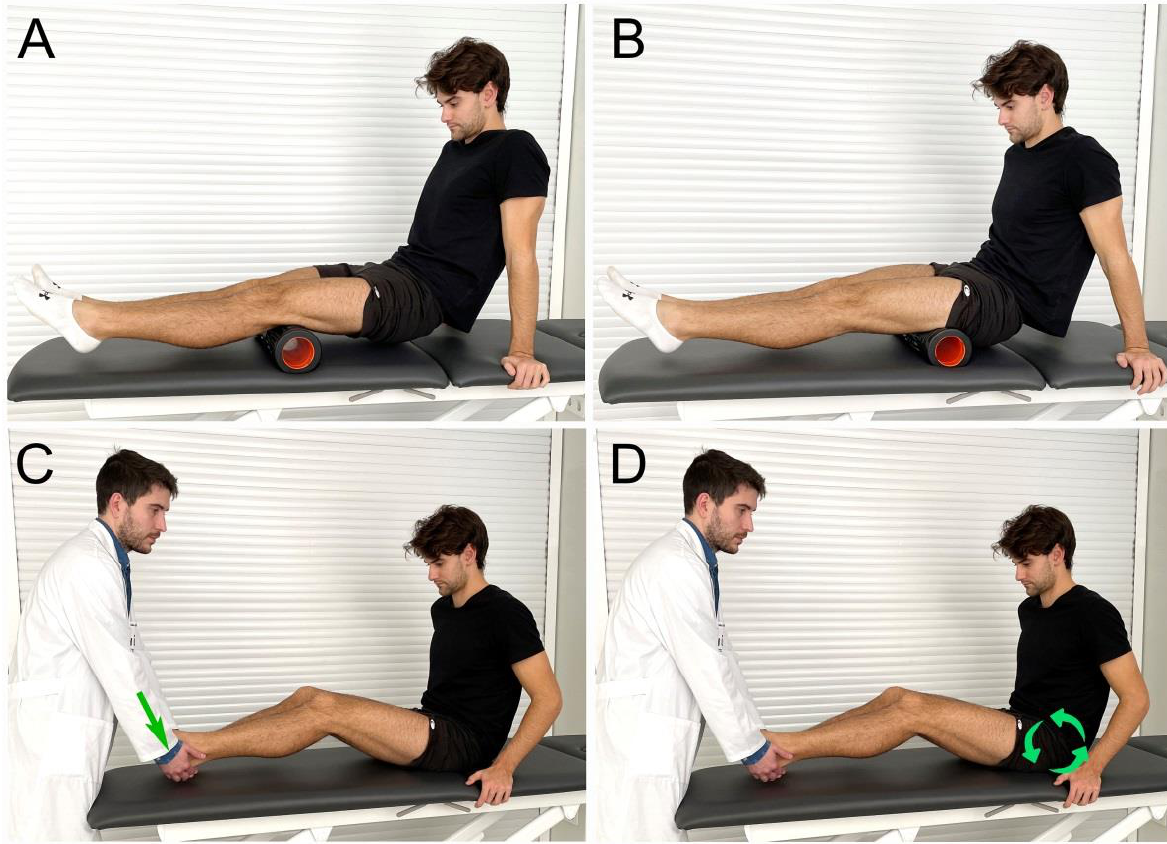
Figure 2. Intervention protocol and data collection. ( A , B ), foam rolling intervention; ( C , D ), proprioceptive neuromuscular facilitation stretching intervention; green arrow, force versus resistance exerted by the patient; green arrows in circle, pelvic anteversion movement performed by patient.